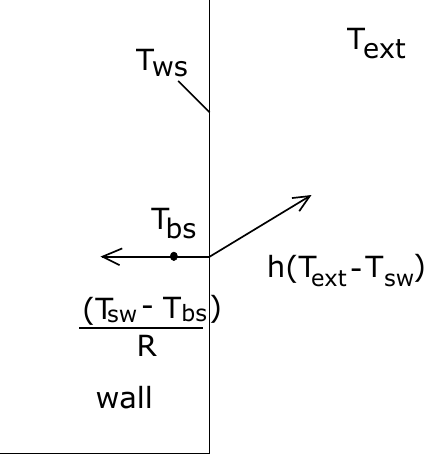
Figure 17. Energy balance on the outside surface of wall in steady-state. T bs denotes temperature below the surface at a certain depth and R is a thermal resistance between the surface and that depth. T ext is the temperature on the external wall surface and T ext,a is external ambient temperature. Given the conduction and convec- tion/radiation flux are equal total heat transfer coefficient is calculated from Equation (6)